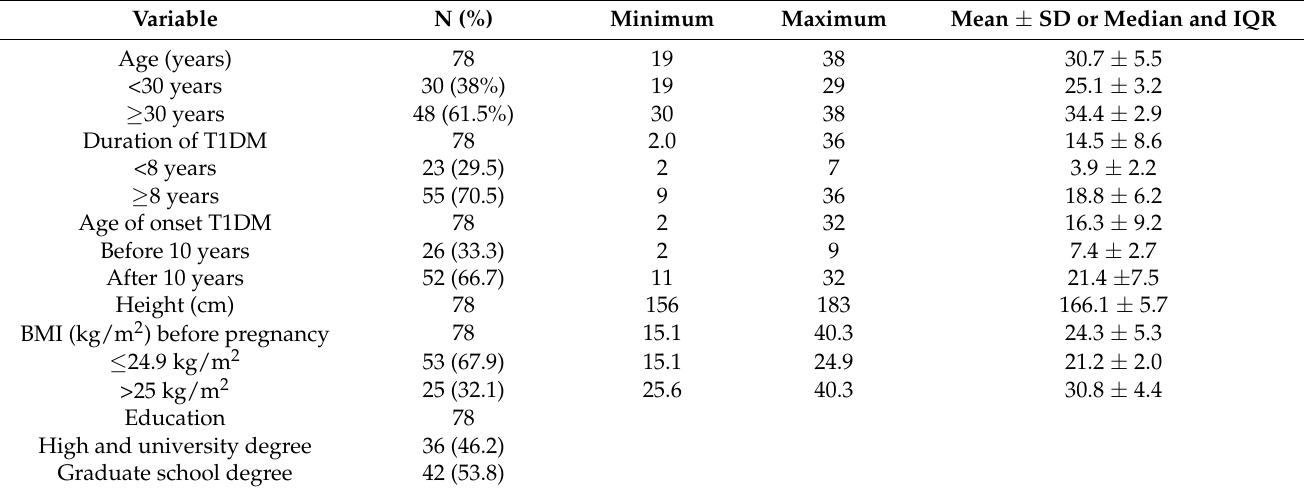
Table 1. Patients’ demographic data in the first